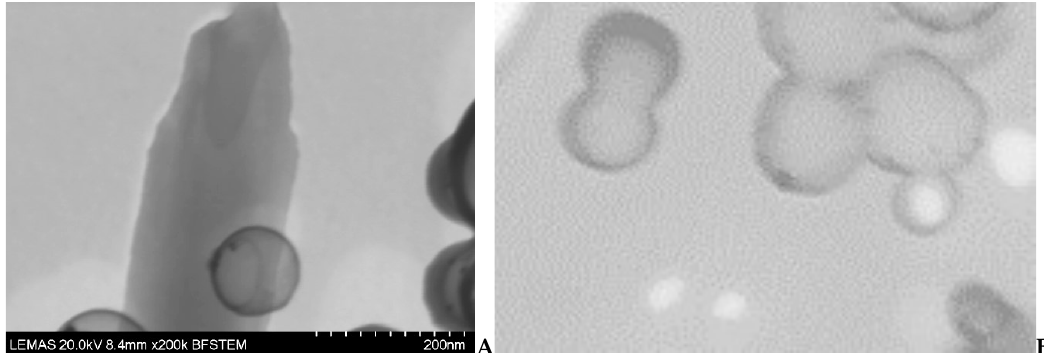
Figure 5. TEM micrographs of TEHA-co-PDLLA 1/140 copolymers in ( A ) low and ( B ) higher magnification.